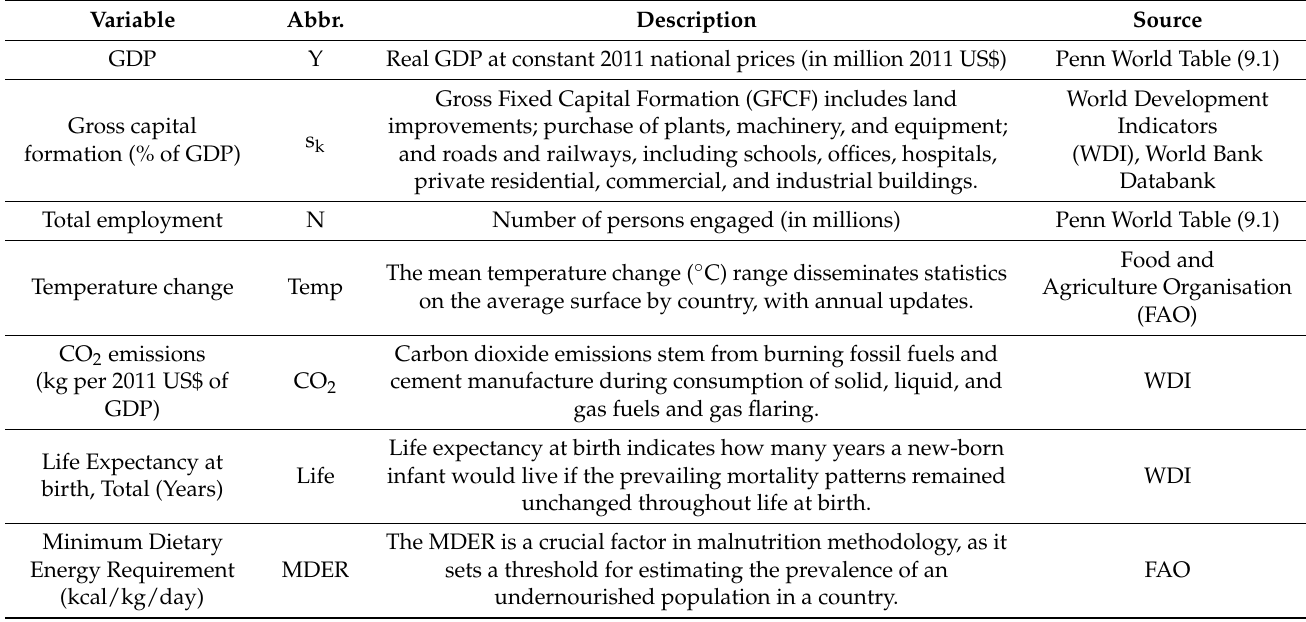
Table 1. Description, Abbreviations, and Sources of Examined